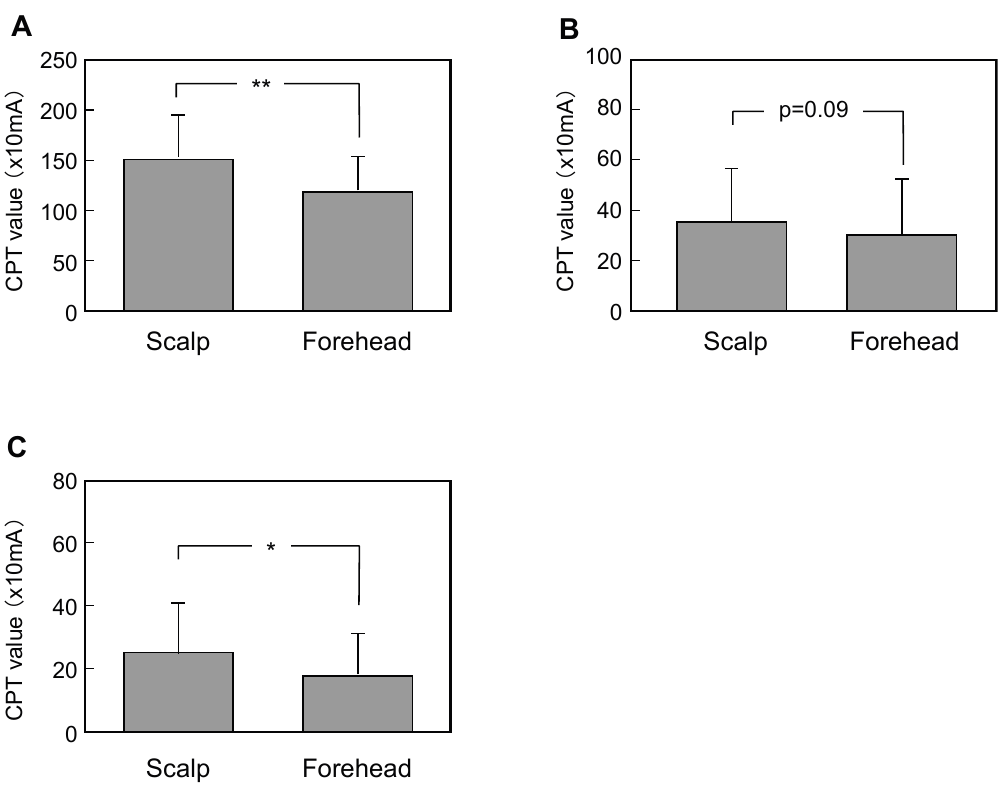
Figure 2. Comparison of measured data for CPT for 2000 Hz ( A ), 250 Hz ( B ), and 5 Hz ( C ) between the scalp and the forehead. Each column indicates the average and the bars show standard deviation. * indicates p < 0.05 and ** indicates p < 0.01 as a significant